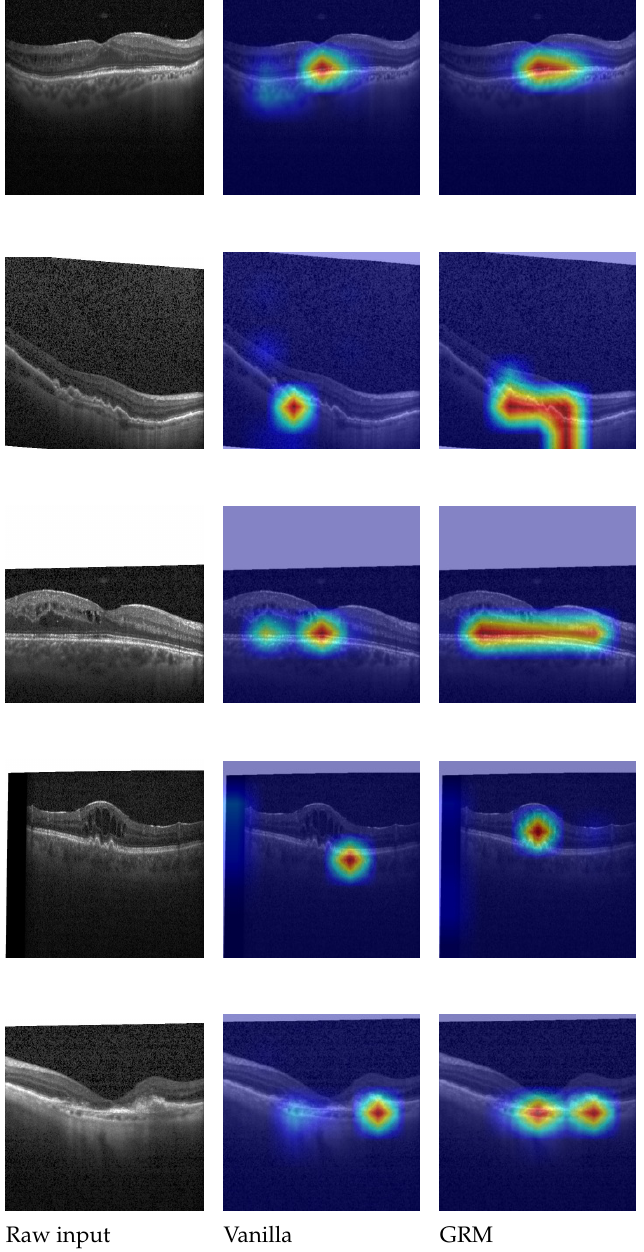
Figure 5. Qualitative comparison between the vanilla ResNet-50 and the ResNet-50 applied with the proposed GRM on five retinal disease cases. Each row denotes a